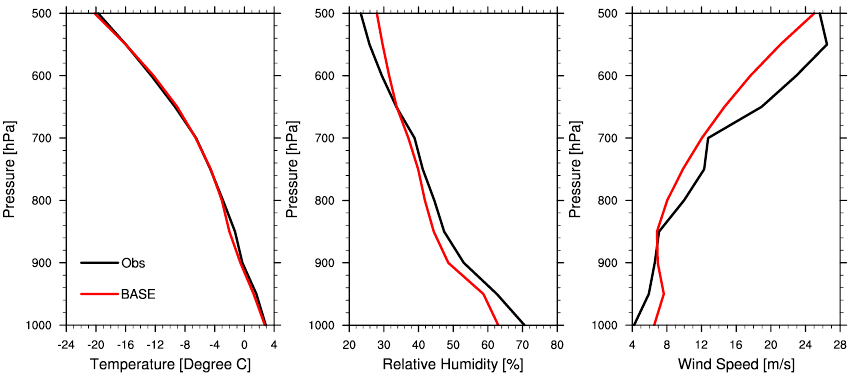
Figure 3. Monthly mean vertical profiles of observed (black line) and simulated (red line) meteorological variables averaged over 36 meteo- rology stations.